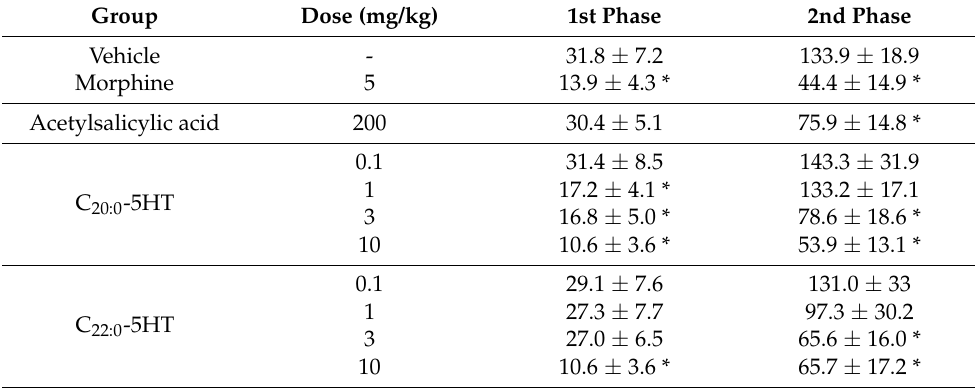
Table 1. Effect of β N -alkanoyl-5-hydroxytryptamides in the formalin-induced licking